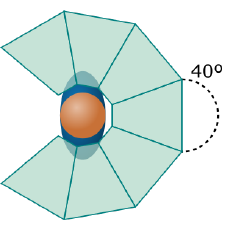
Figure 4 shows three types of trajectories regarding two agents: diverging trajectories (on the left), parallel trajectories (on the center) and converging trajectories (on the right). In the first two trajectories, there is no risk of collision, whereas in, the third one, the collision will occur if both agents keep their current trajectories. The case on the center image represents the turning point where the agent might collide if it does any change toward the other agent. The closer the agents are, the lower will be the angle necessary for them to see each other (Figure 5).